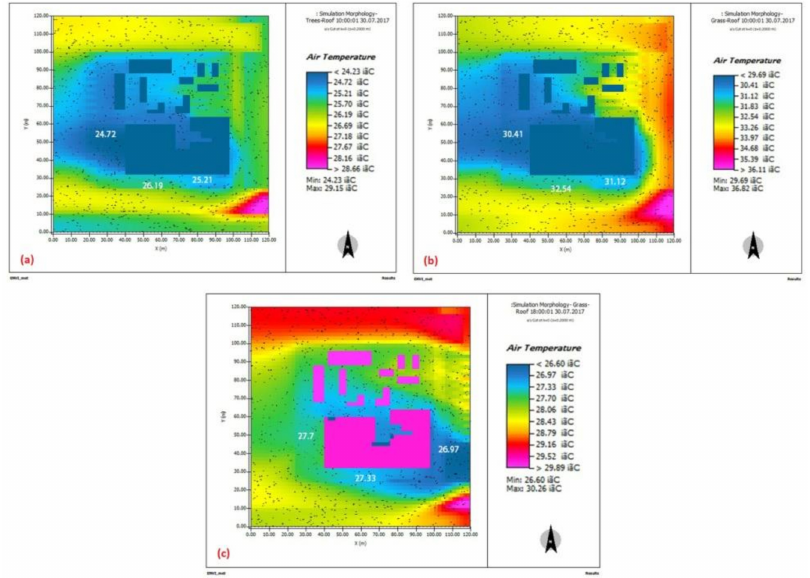
Figure 11. ENVI-met simulation outputs for T air at ( a ) 10:00; ( b ) 14:00; and ( c )